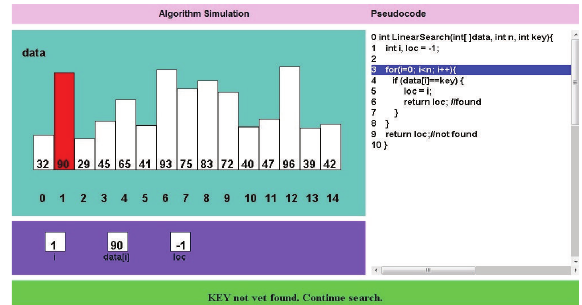
Figure 4: Algorithm simulation field, pseudocode display, variable, and message fields for AlgoVis1.